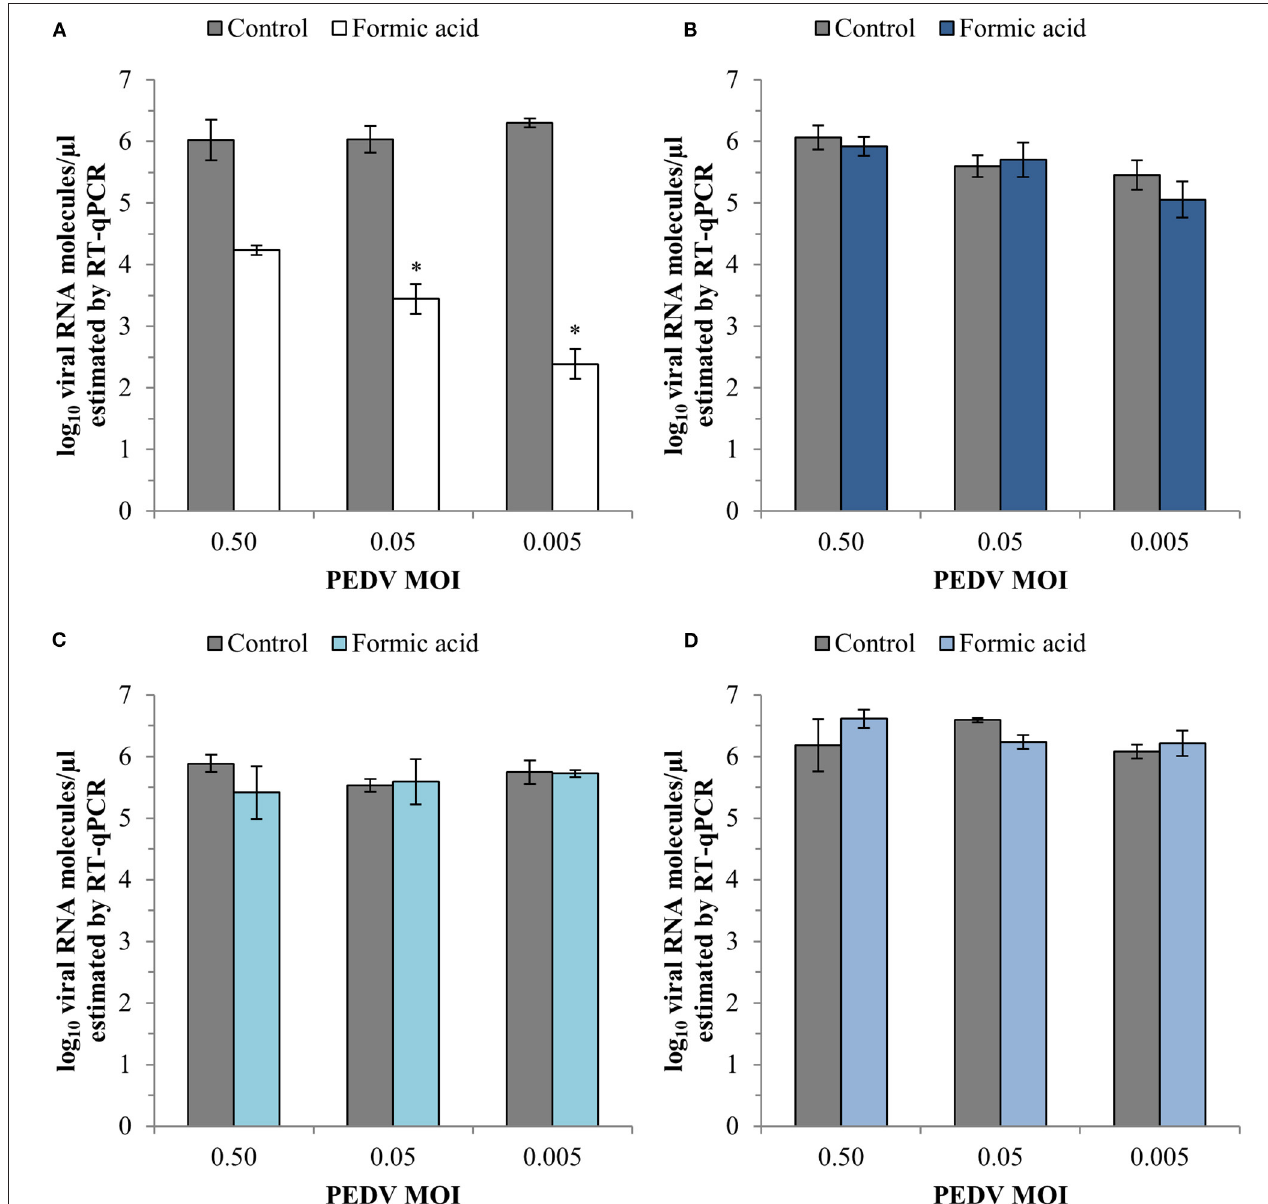
FIGURE 4 | Effect of a treatment with 1,200 ppm of formic acid on the different steps of the infection cycle of PEDV: replication (A) , viral inactivation (B) , attachment (C) and entry (D) . Data are expressed as mean ± standard deviations of log 10 viral RNA molecules/ µ l) estimated using RT-qPCR. *Statistically significant differences with regard to controls ( p <